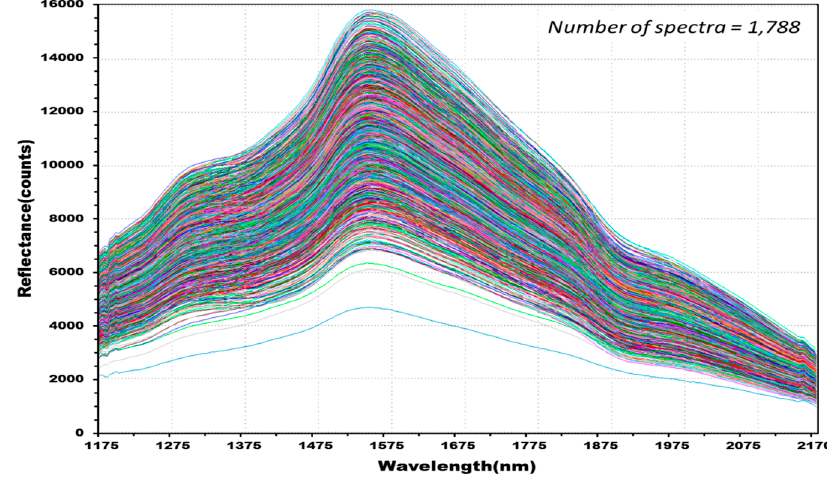
Figure 9. Total NIR reflectance spectra obtained from Fusarium -infected hulled barley samples (298 kernels) in the experimental group.